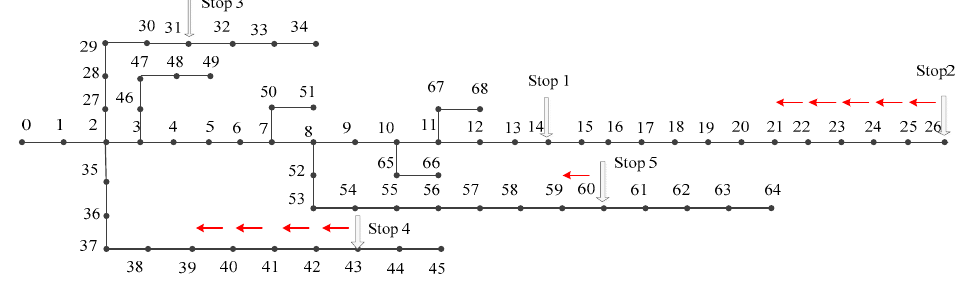
Figure 15. The reverse flow of case 4 at 18:00 p.m. Table 6. The risk assessment results of bus 26.